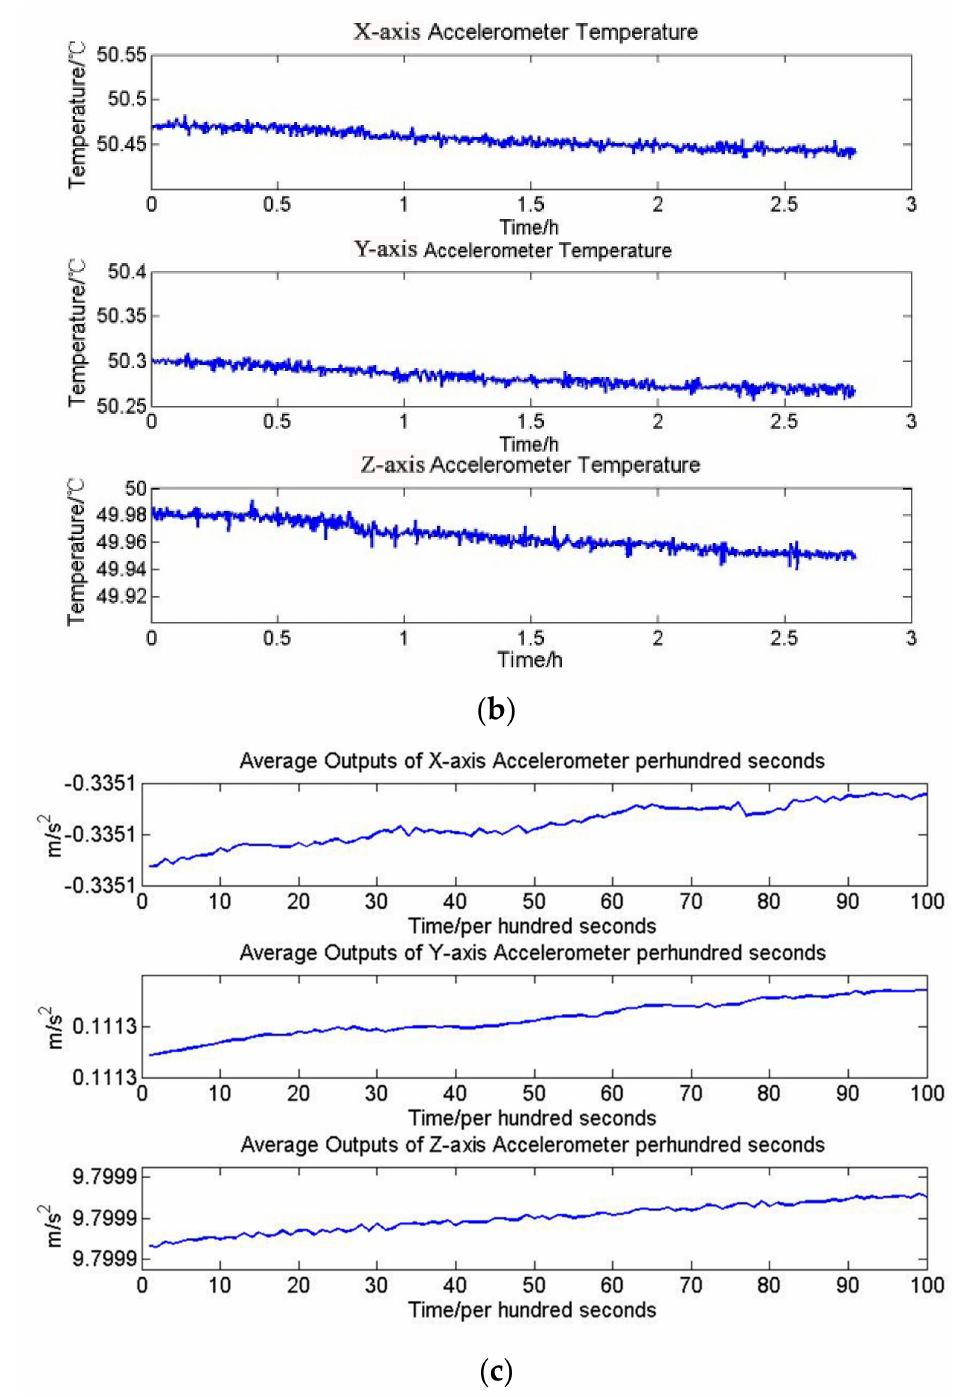
Figure 8. ( a ) Environment temperature variation, ( b ) accelerometers temperature variation, and ( c ) the average outputs of accelerometers per hundred